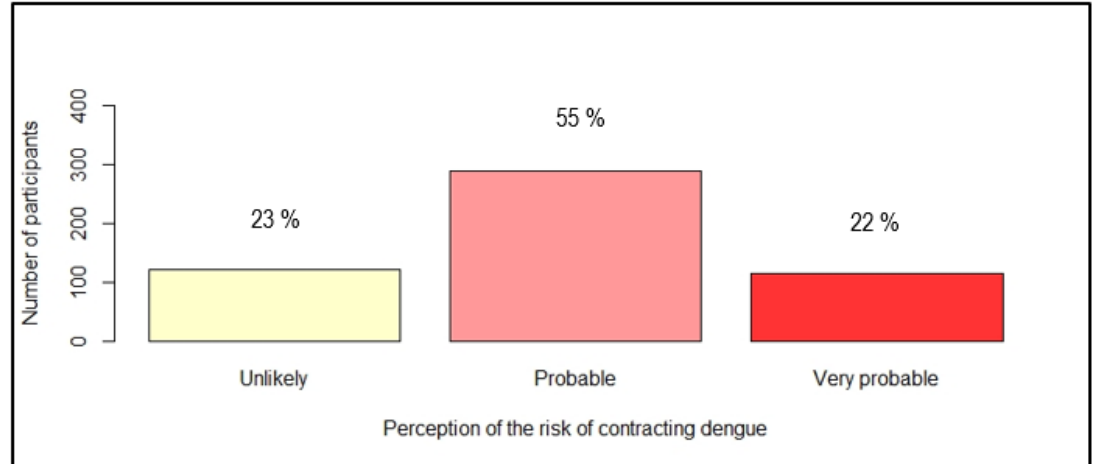
Figure 3. Distribution of participants according to their perception of the risk of contracting dengue in the coming five years ( n = 525).